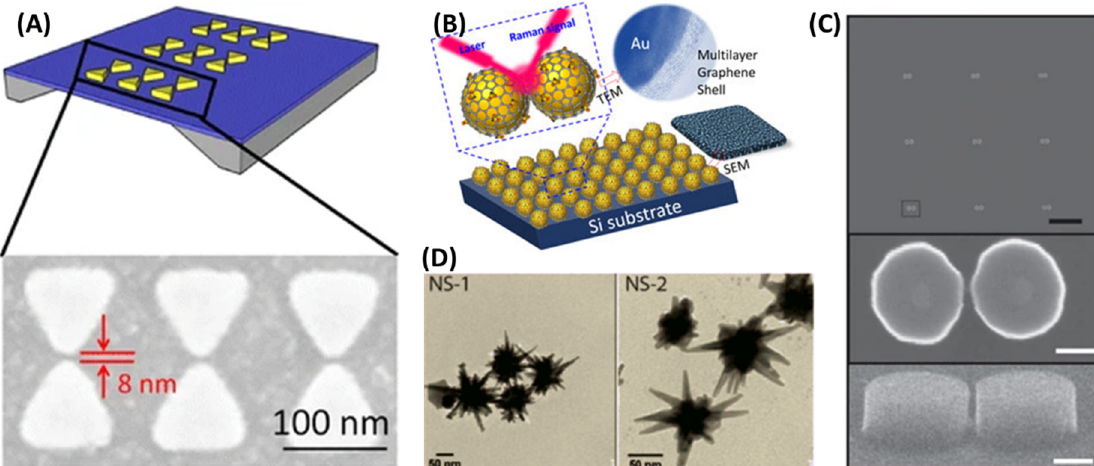
Figure 1. Examples of SERS substrates. ( A ) Au bowtie nanoantenna array deposited on a Si 3 N 4 membrane. ( B ) Graphene- encapsulated AuNPs on Si substrate. ( C ) Array of Si dimer nanoantennas: SEM image of the array of nanostructures, SEM top-view and lateral-view images of a single nanoantenna. ( D ) Gold nanostars with different spike morphologies. SEM: scanning electron microscopy. TEM: transmission electron microscopy. Reproduced with permission from [7–9]. Copyright 2015, Springer. Copyright 2015, Nature Publishing Group. Copyright 2014, Royal Society of Chemistry.